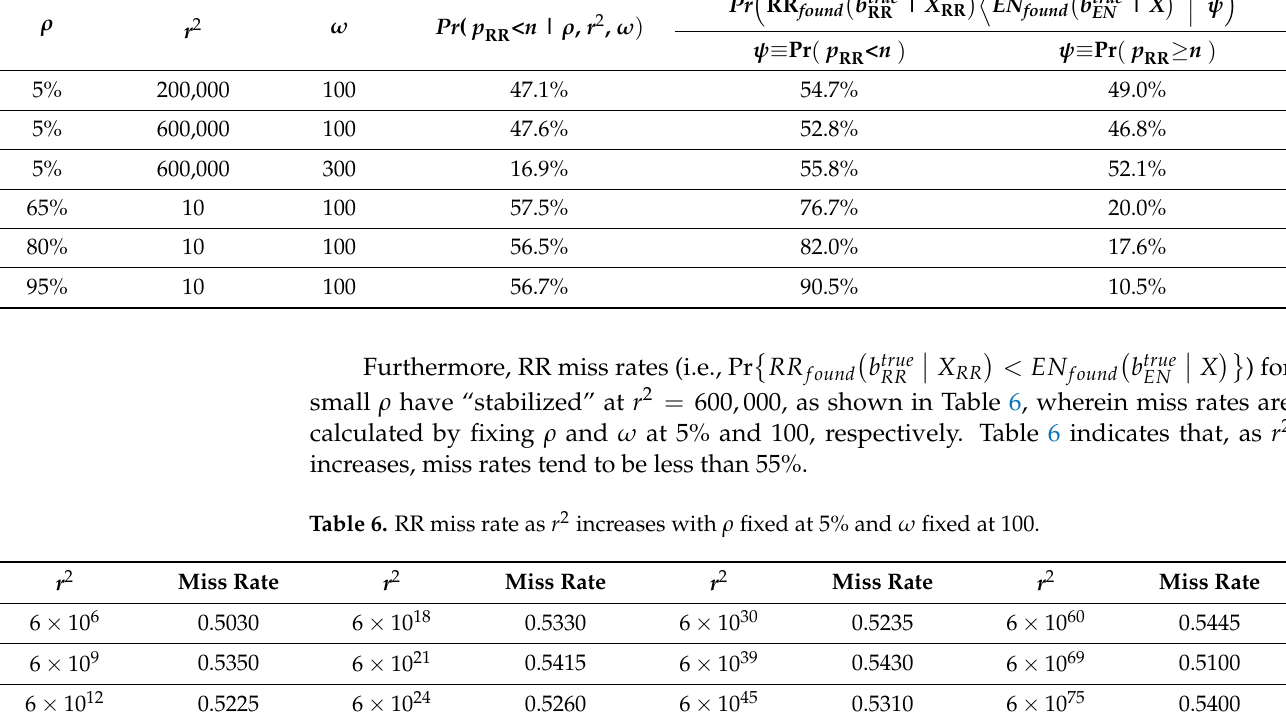
(cid:12) (cid:1)(cid:9) ≥ (cid:0) b true (cid:12) X EN